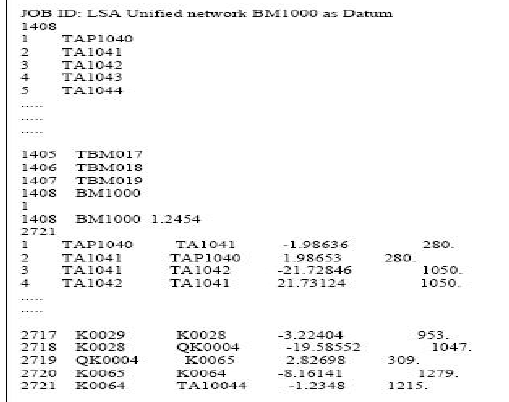
Figure 5. Sample of MoreFix input file format